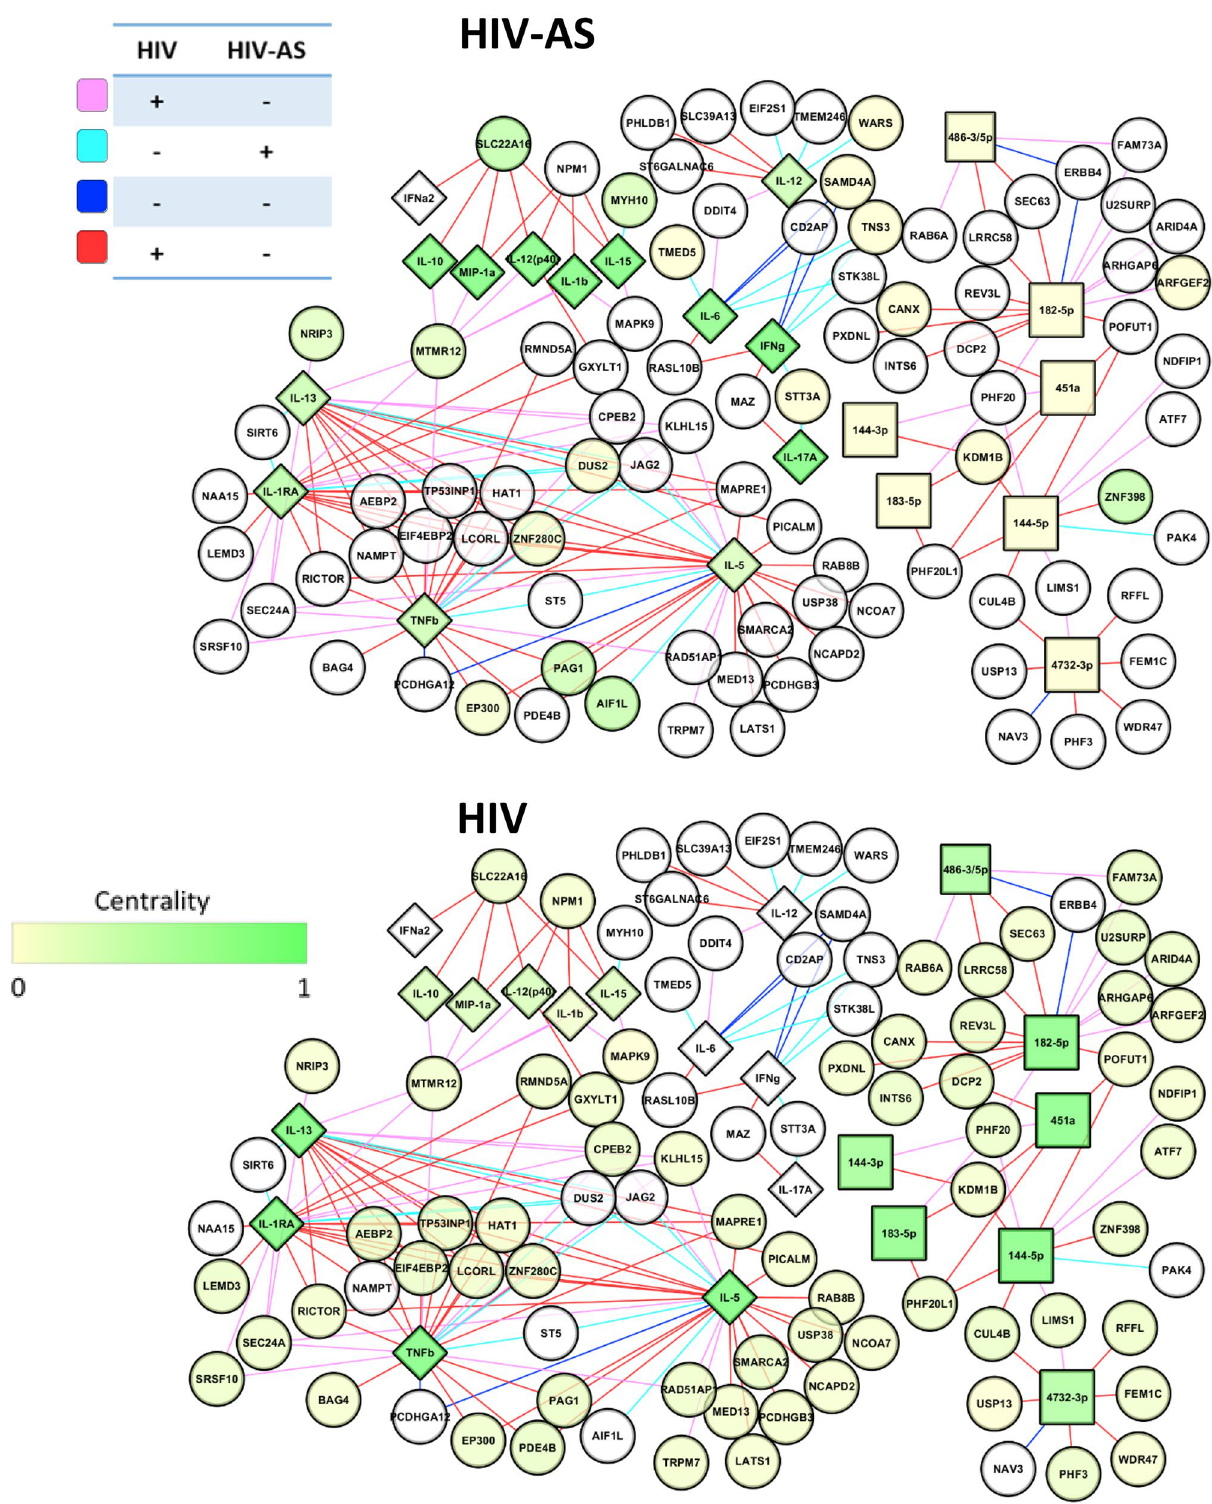
Figure 5. Regulation of AS associated signaling in the context of HIV. The network of association between miRNA, mRNA and cytokines in HIV+ people with and without AS. Squares represent miRNA, circles represent mRNA and diamonds represent cytokines and chemokines. Coloring of nodes indicates centrality score for HIV+ AS+ group (top) or HIV group (bottom). Coloring of edges represents sign of correlation between nodes in HIV+ or HIV+ AS+ groups as shown in the edge color key. Analysis performed in R (ver 3.5.1) 57 , with graphical output from Cytoscape (version 3.7.0) 67